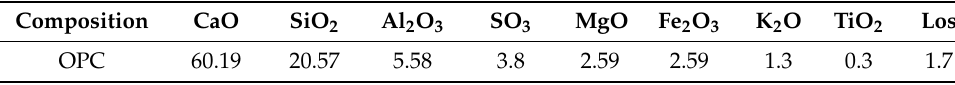
Table 1. Chemical composition of OPC (wt.%).